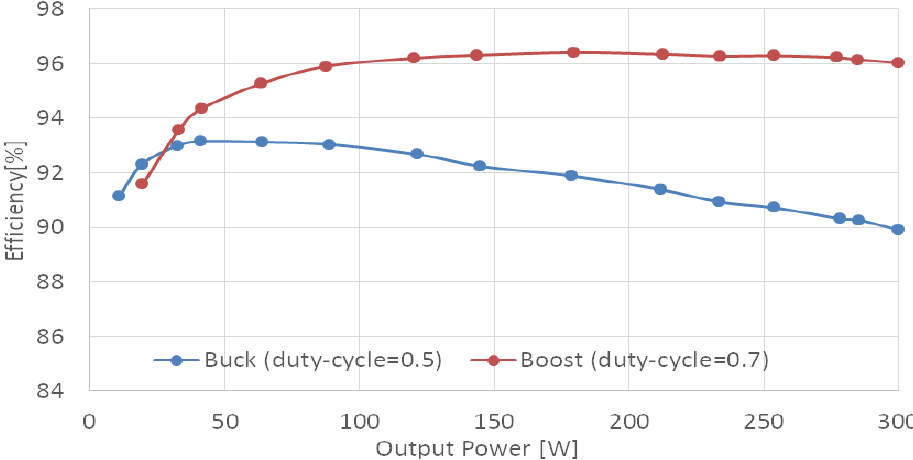
Figure 25. Experimental results for the input and output voltage in transient mode considering this converter operating a PV system.